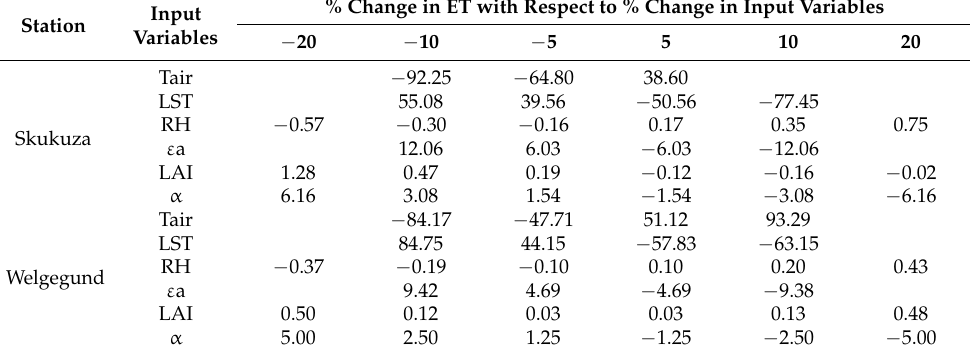
Table 8. Sensitivity of ET to input